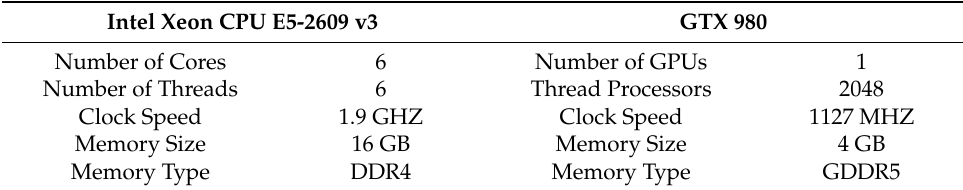
Table 1. Configuration of